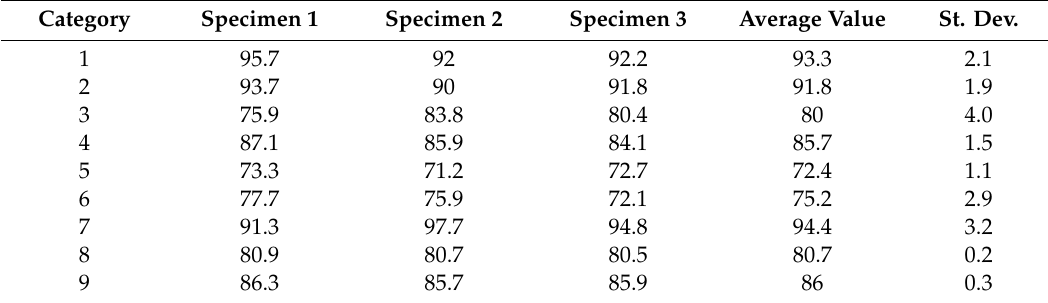
Table 4. Experimental Shore A hardness for the di ff erent